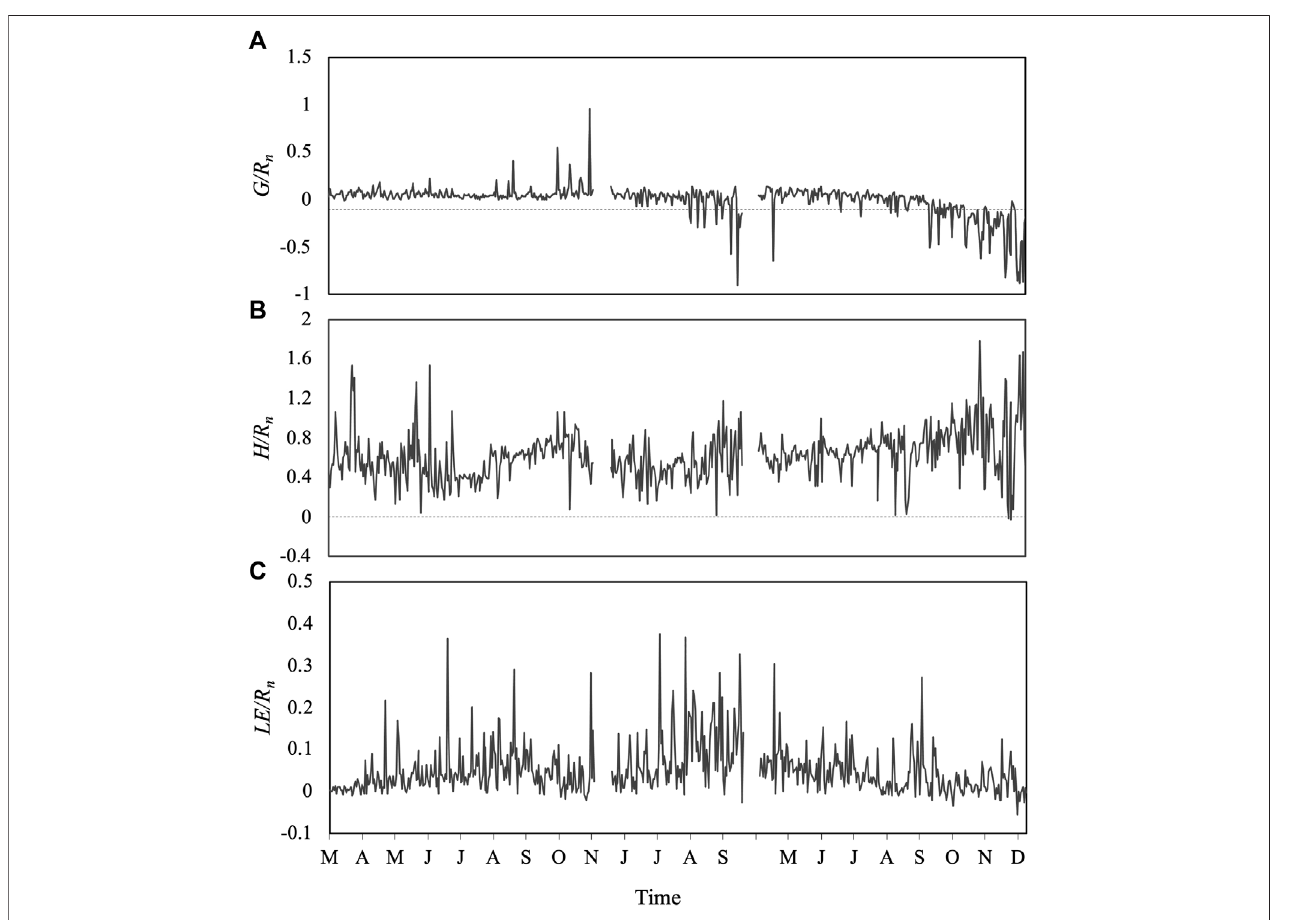
FIGURE 4 | Seasonal and interannual variation of energy distribution of the desert ecosystem in Dengkou County, Inner Mongolia.